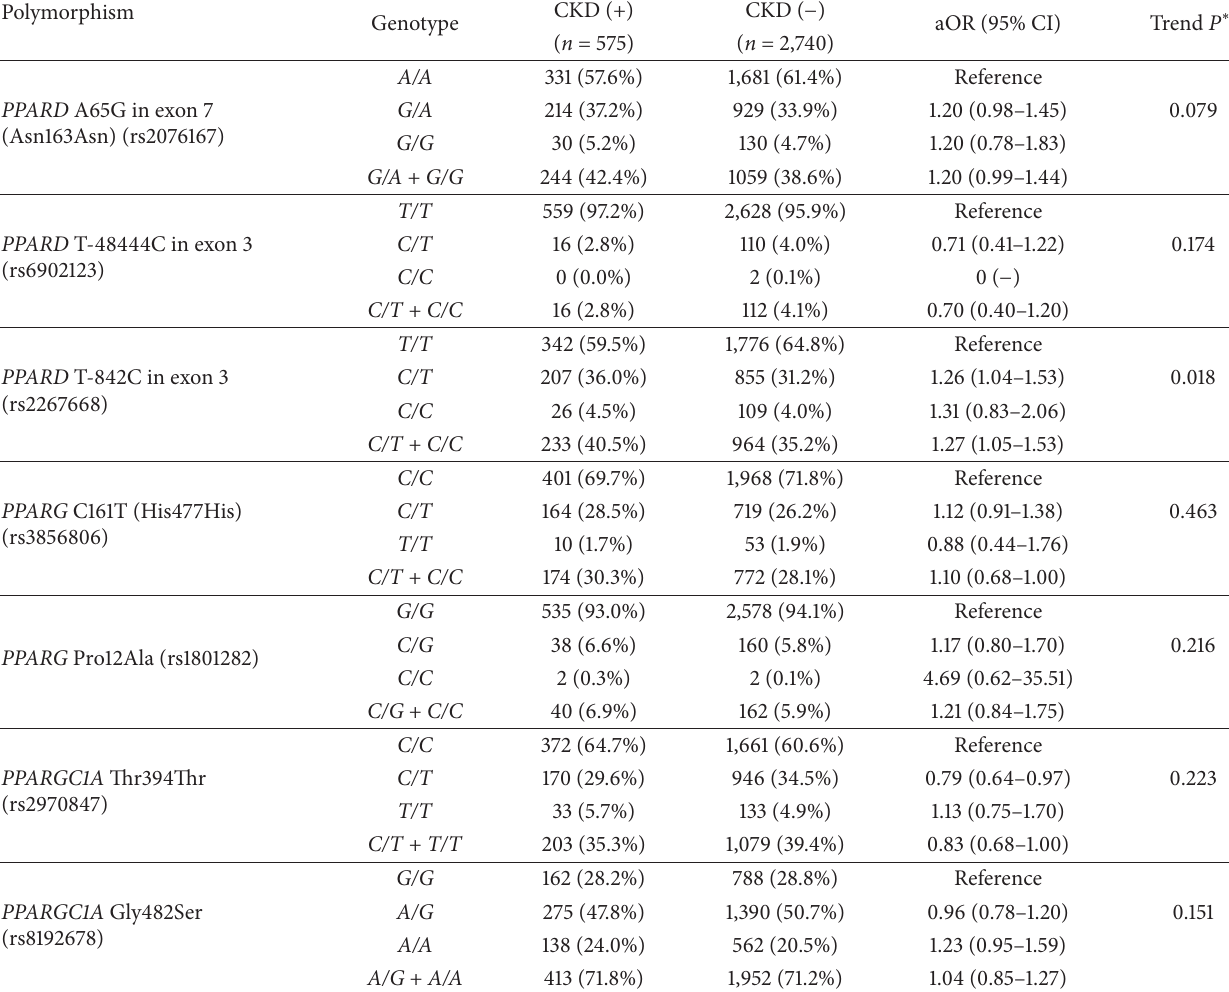
Table 2: PPARD , PPARG, and PPARGC1A polymorphisms and risk of